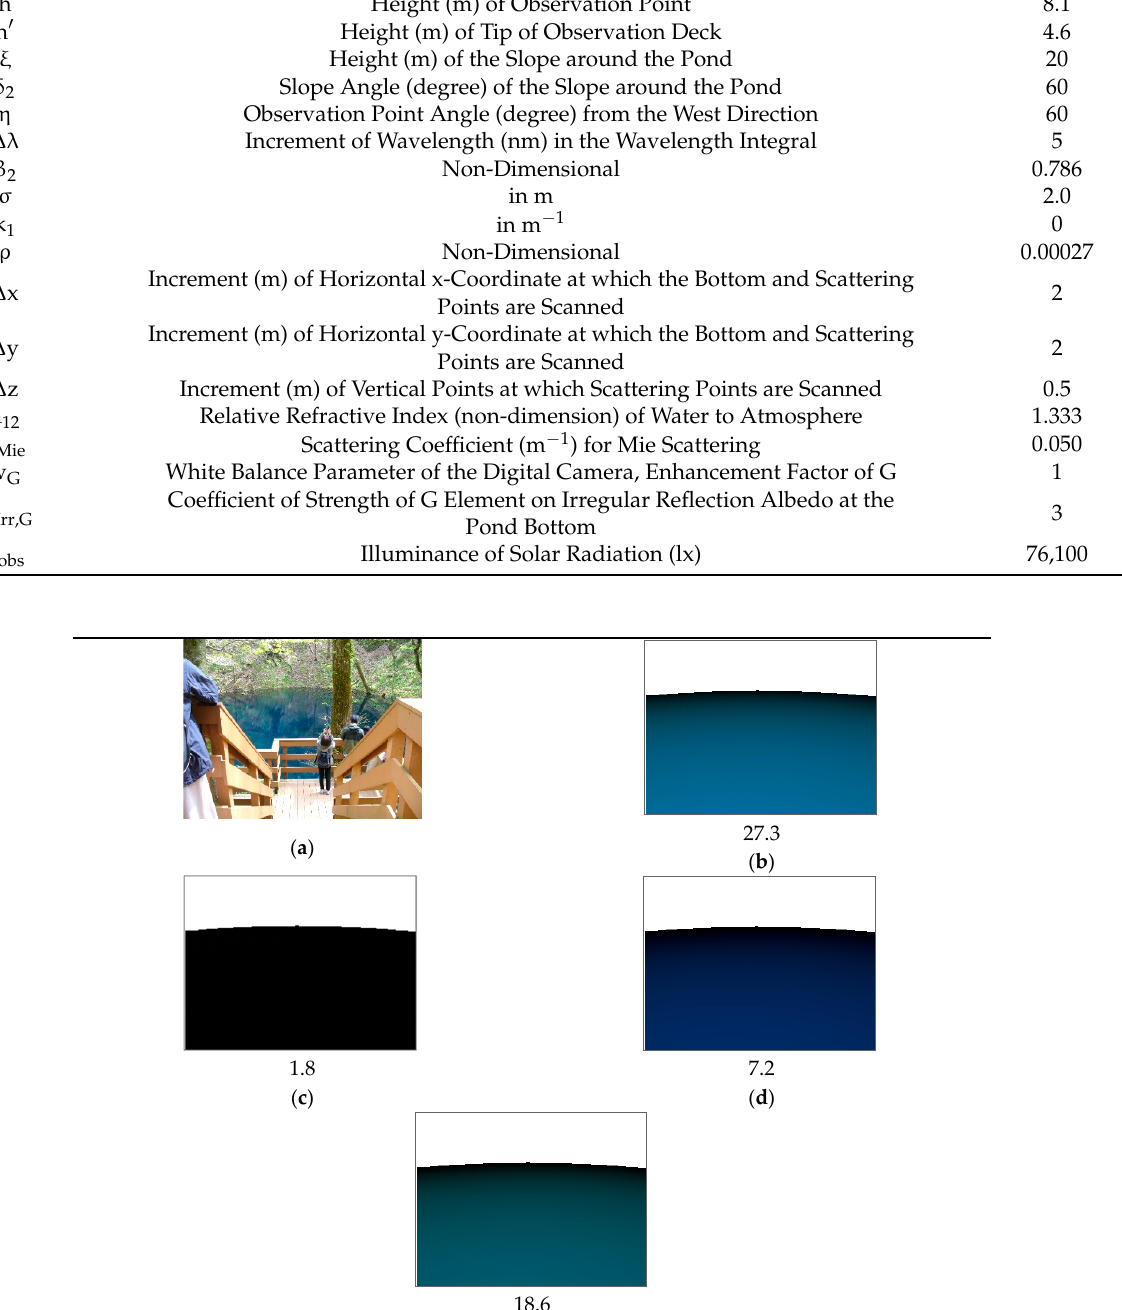
( b ) ( c ) Figure 16. Relationship between observed and theoretical RGB values of the model fitting in image analyses (n = 245). ( a ) R values, ( b ) G values and ( c ) B values.